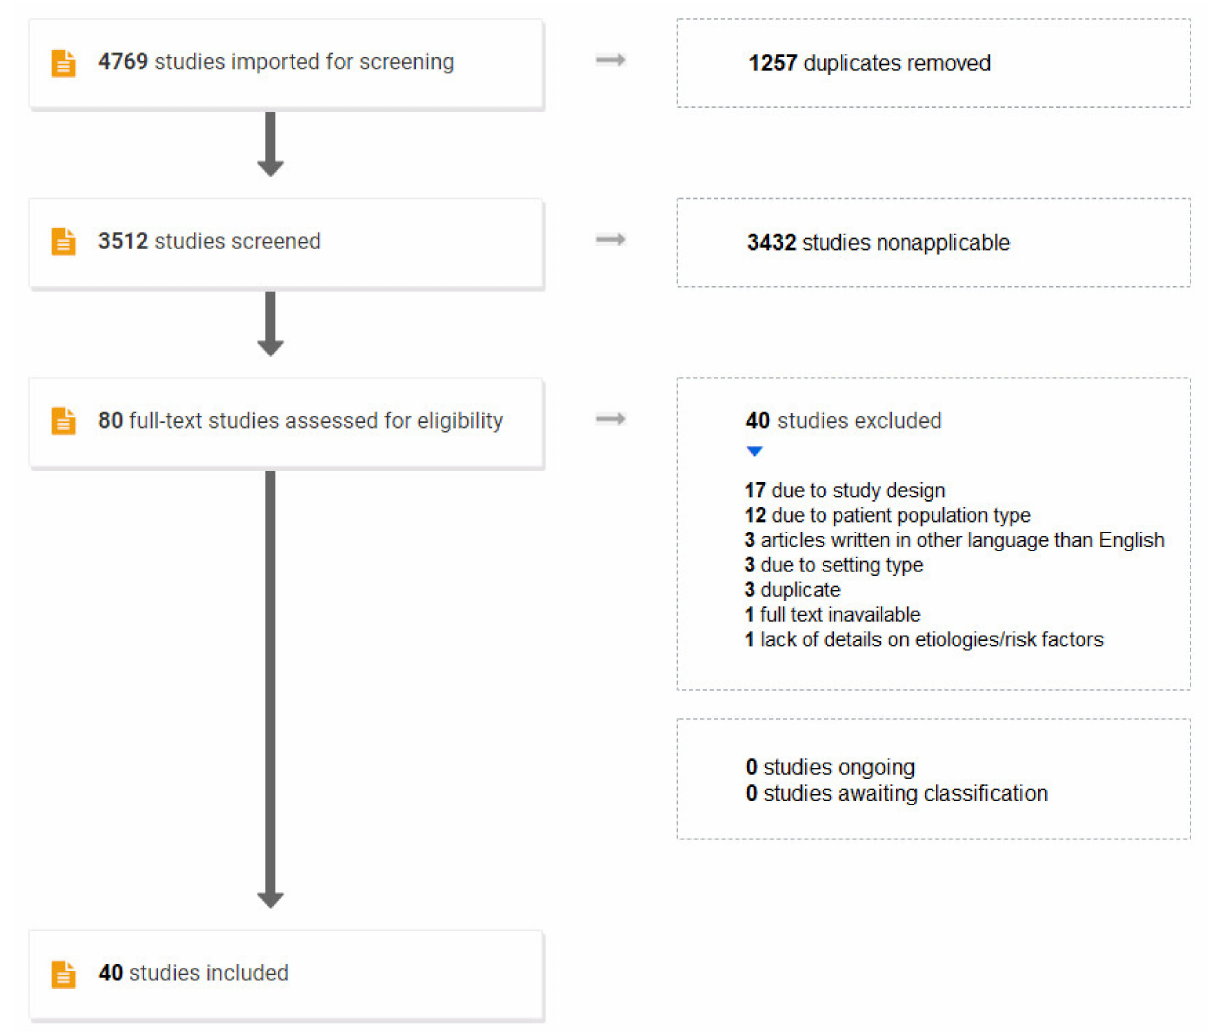
Figure 1. Pediatric spontaneous intracranial hemorrhage search strategy using PRISMA